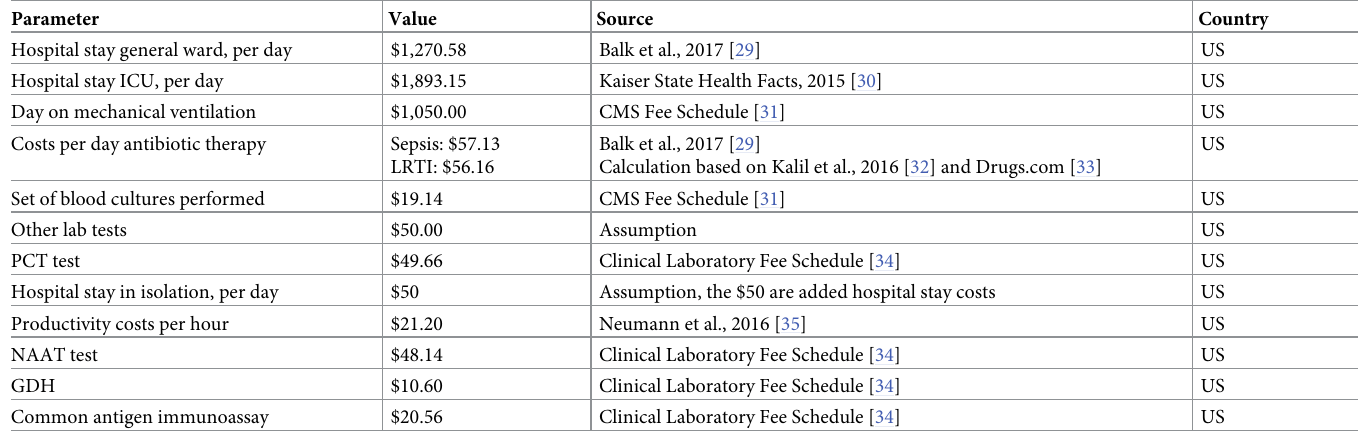
Table 3. Cost input data for sepsis and LRTI, all based on the